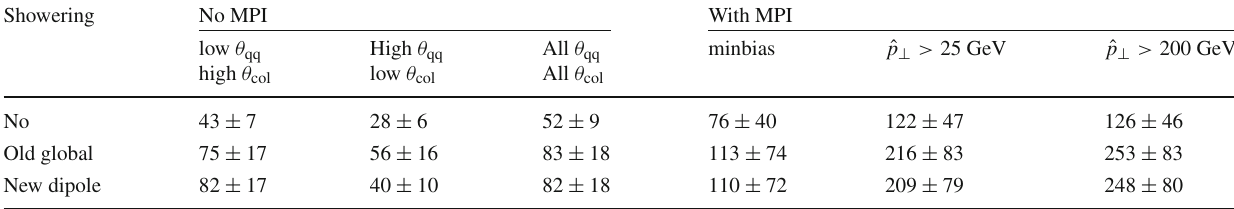
Table 3 Average charged event multiplicity and the width of the multi- plicity distribution without showers, or with the old global or new